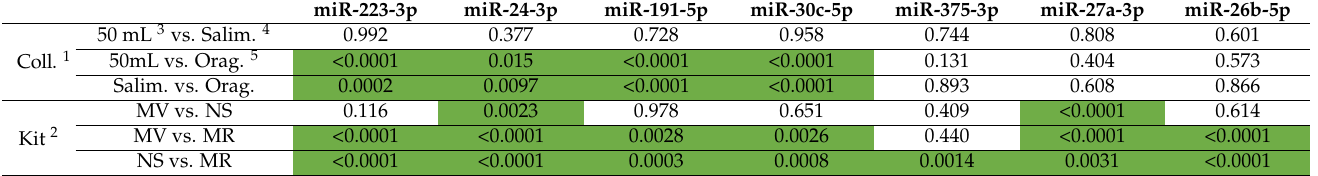
Table 3. Comparison of miRNA expression in grouping the results by collectors and extraction